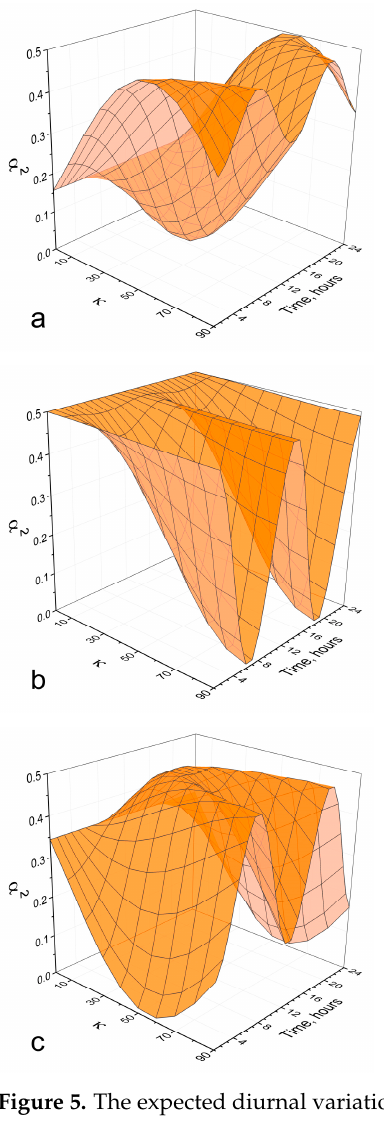
Figure 5. The expected diurnal variations for counters placed in Moscow for different orientations and different angle κ between vector of E-field and the axes of the Earth; ( a )—vertical orientation, ( b ) east–west orientation, ( c ) north–south orientation.